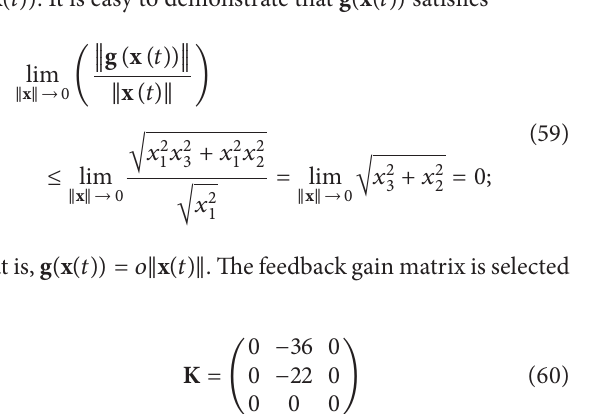
Adding control input u (𝑡) = Kx (𝑡) to system (57), the controlled system can be rewritten as 𝐶 0 𝐷 𝛼 𝑡 x (𝑡) = Ax (𝑡)